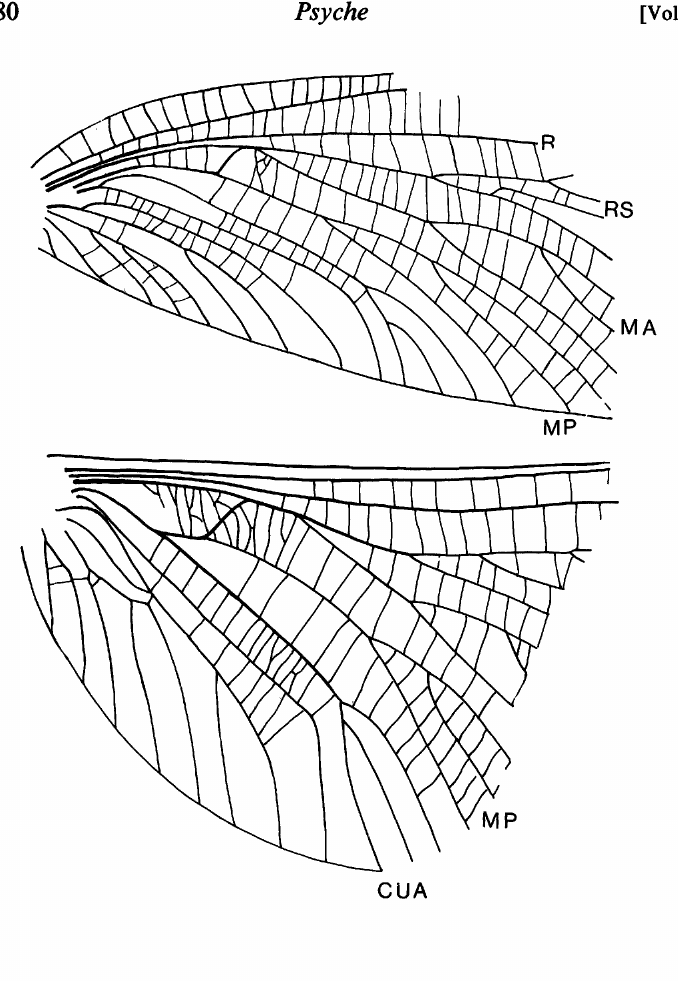
Fig. 5. Lithoneura lameerei Carpenter. Venational pattern of fore wing (upper figure) and hind wing (lower